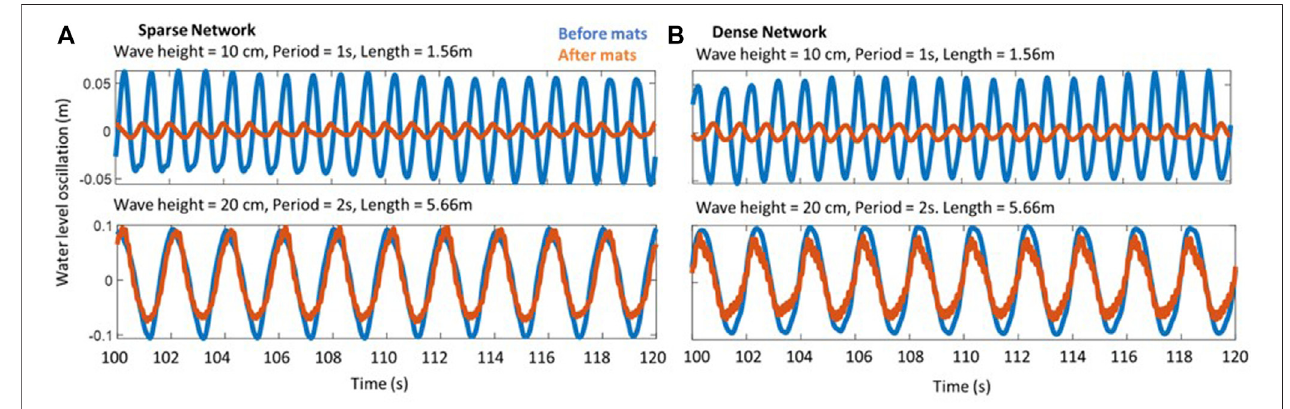
FIGURE6| Samplewavegage signals from the sparse network (A) and thedense network (B) for waveheightsof10 cm(top) and 20 cm (bottom). Incident wave conditions (blue) are higher than wave conditions after the network (red) but the damping effect of the network changes depending on the wave conditions and network con fi guration. The gages used here are located in the middle of the basin in the direction of wave propagation.